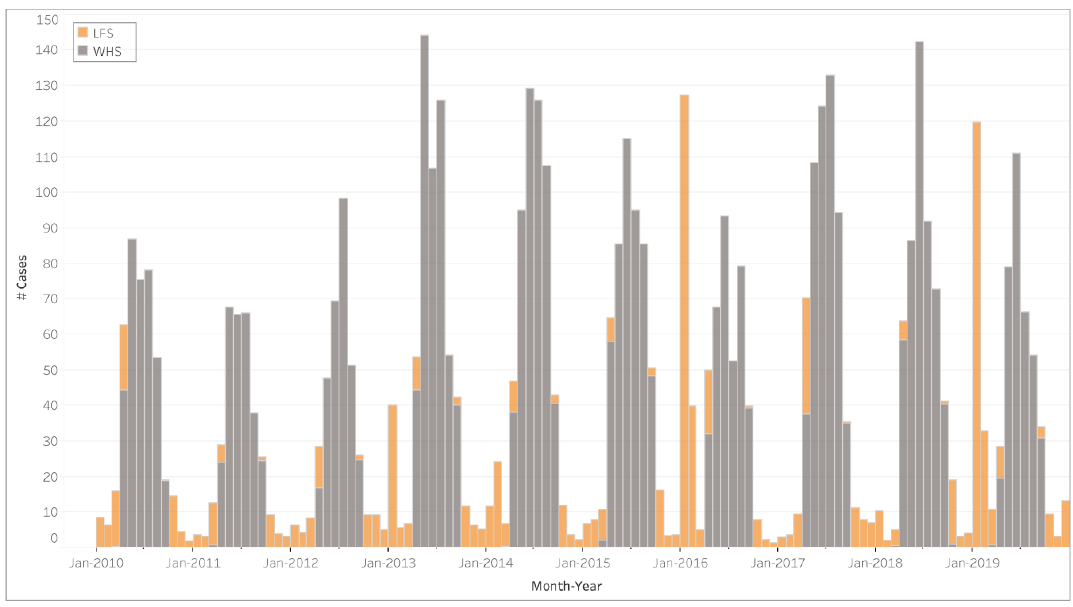
Figure 3. Total estimated number of cases attributable to wood heater smoke (WHS) and landscape fire smoke (LFS) by month and year.